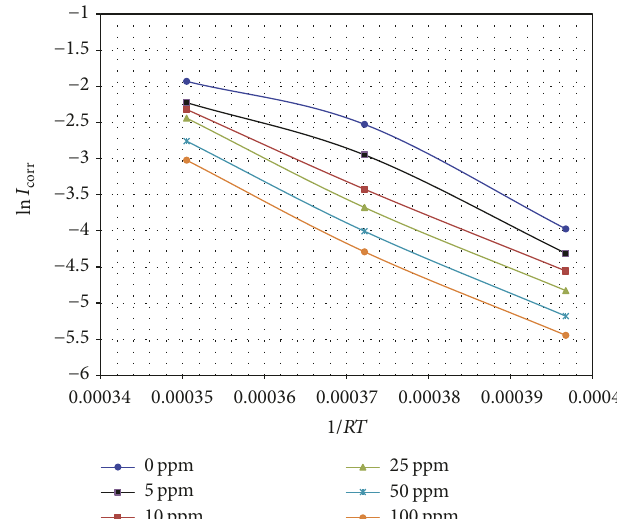
Figure 9: ln (𝐼 corr ) - 1/𝑅𝑇 relationship for the API X-70 steel evaluated in CO 2 -saturated saline solution as a function of the inhibitor